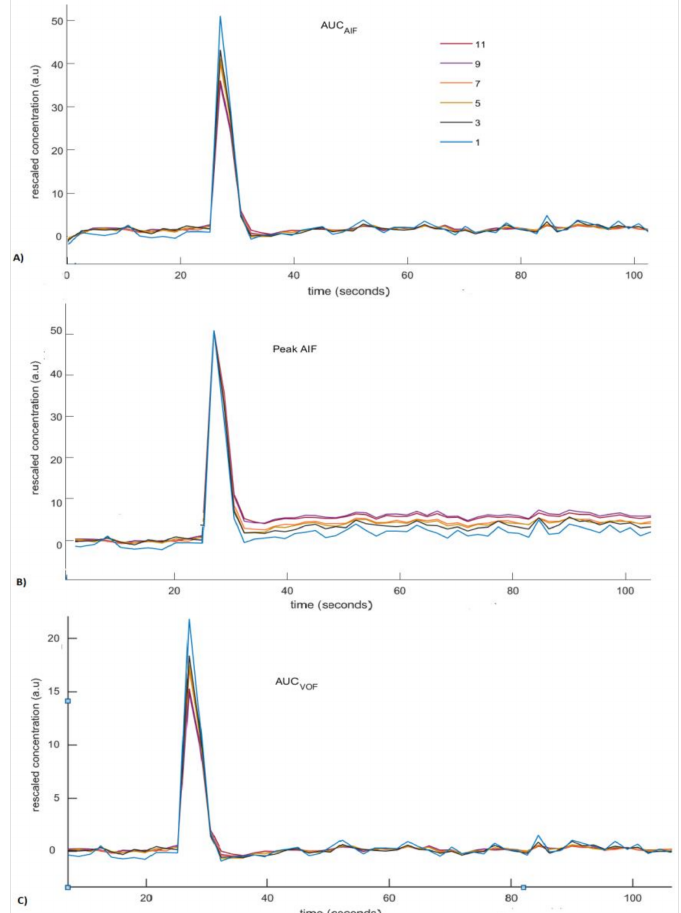
Figure 3. Rescaled concentration curves of arterial input functions (AIFs) generated using different scaling methods. The legend in ( A ) indicates the width (in voxels) of ROI used for measuring the AIF. ( A ) Rescaled AIFs generated using scaling by AIF approach. ( B ) Rescaled AIFs generated using scaling by matching peak height approach. ( C ) Rescaled AIFs generated using scaling by VOF approach.